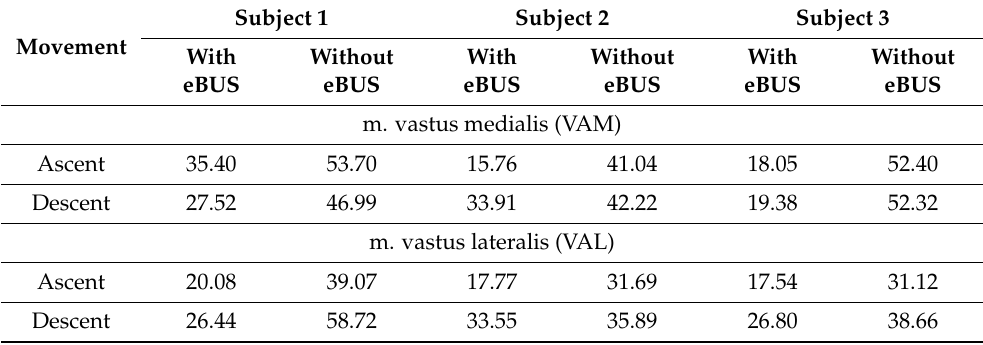
Table 4. Integrals of the normalized median sEMG curves of m. vastus medialis (VAM) and m. vastus lateralis (VAL) in time normalized stance phase with and without the exoskeleton per subject (S1, S2, S3) and movement (ascent,